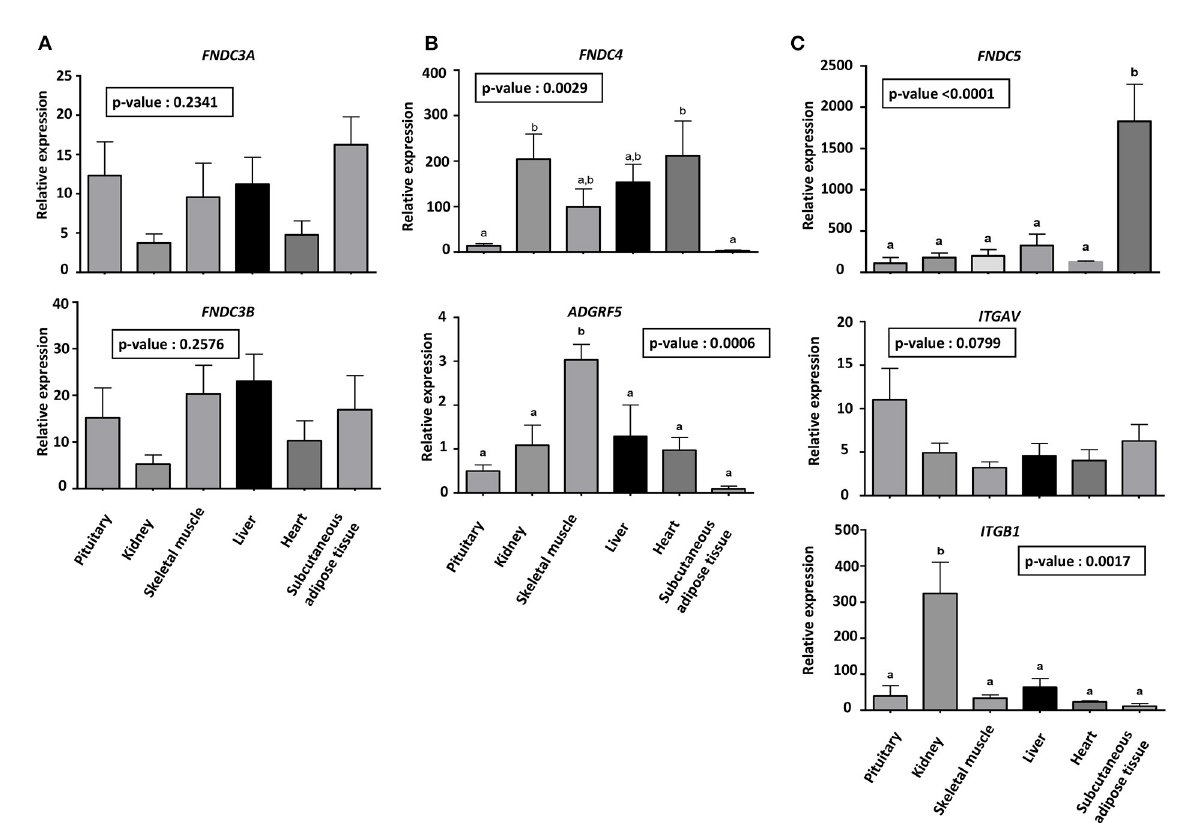
FIGURE3 Abundance of mRNA encoding FNDCs, ADGRF5, ITGAV and ITGB1 (A–C) in various bovine tissues. Abundance of mRNA was determined by real-time RT-qPCR. Data are expressed as mean ± SEM (n = 8 animals) and analysed by a one-way analysis of variance (ANOVA). Different letters indicate a significant difference between tissues ( p <